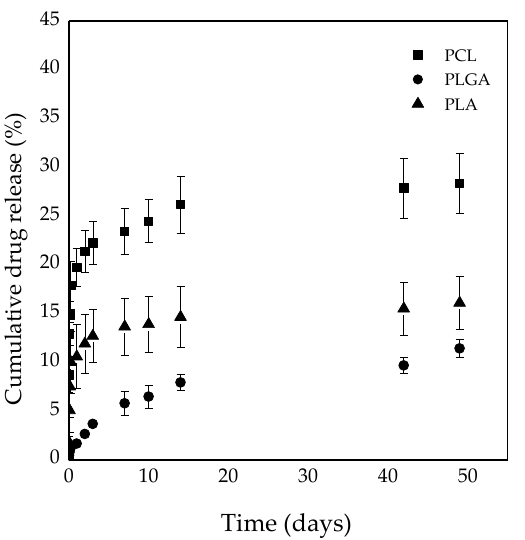
Figure 6. In vitro release profile for PLGA, PCL, and PLA MPs. PLGA: poly(lactic- co -glycolic acid), PCL: poly( ε -caprolactone), PLA: poly(lactic acid).